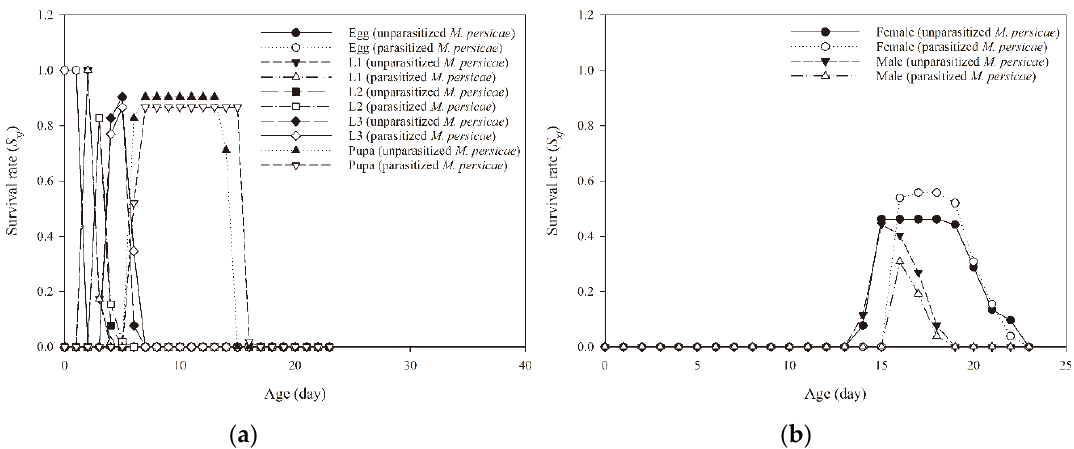
Figure 1. Age-stage specific survival rate ( S xj ) of immature ( a ) and adult ( b ) Aphidoletes aphidimyza that fed on unparasitized and parasitized Myzus persicae by Aphidius gifuensis.